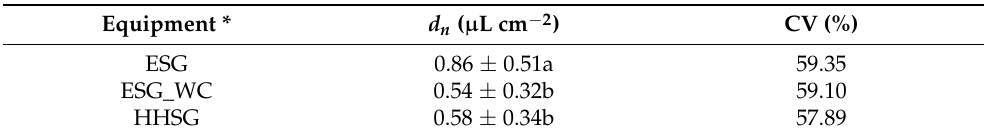
Table 3. Normalised deposition per unit leaf area (mean ± SD) in µ L cm − 2 ( d n ) and the coefficient of variation (CV) for the deposition distribution in the crop canopy, in